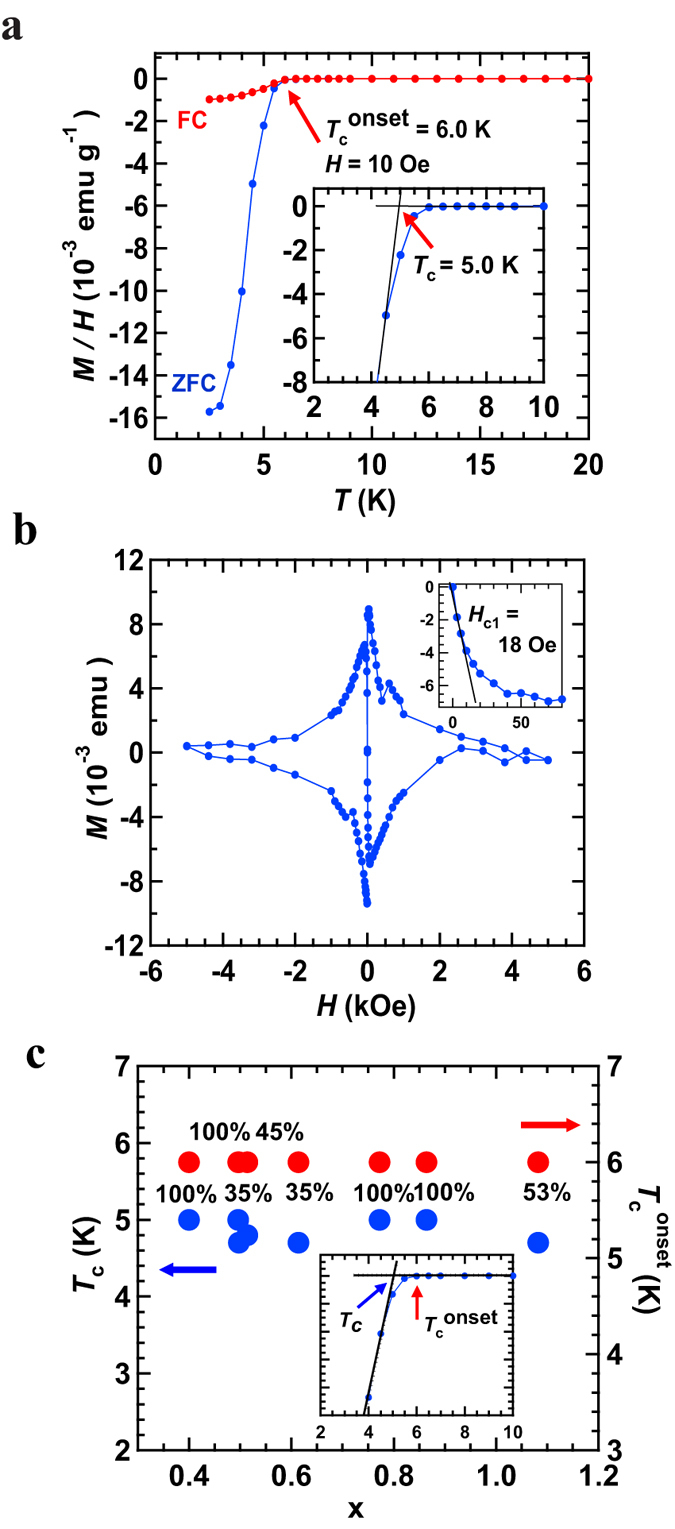
(a) M/H vs. T plots of the (NH3)yNa0.5MoSe2 agglomerations in ZFC and FC modes (H = 10 Oe). Inset in (a) shows the method used to determine Tc. (b) M – H curve measured at 2 K for the (NH3)yNa0.5MoSe2 agglomerations. In the inset of (b), the expanded M – H curve is shown together with the fitted line. The chemical composition of (NH3)yNa0.5MoSe2 used in (a,b) was determined to be (NH3)0.4(1)Na0.41(1)MoSe2.04(1) (see text). (c) x-dependence of Tc and Tconset in (NH3)yNaxMoSe2; x was evaluated from the EDX. In (c) the shielding fraction is evaluated using the ρ determined using each chemical stoichiometry for (NH3)yNaxMoSe2; y is assumed to be 0.4. The inset of (c) shows how to determine the Tc and Tconset.